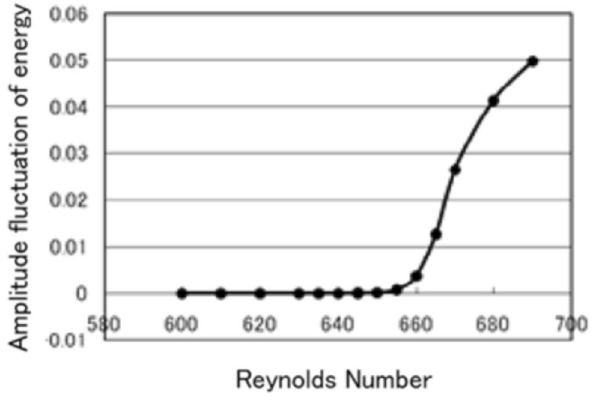
Fig. 3 Amplitude fluctuation of energy